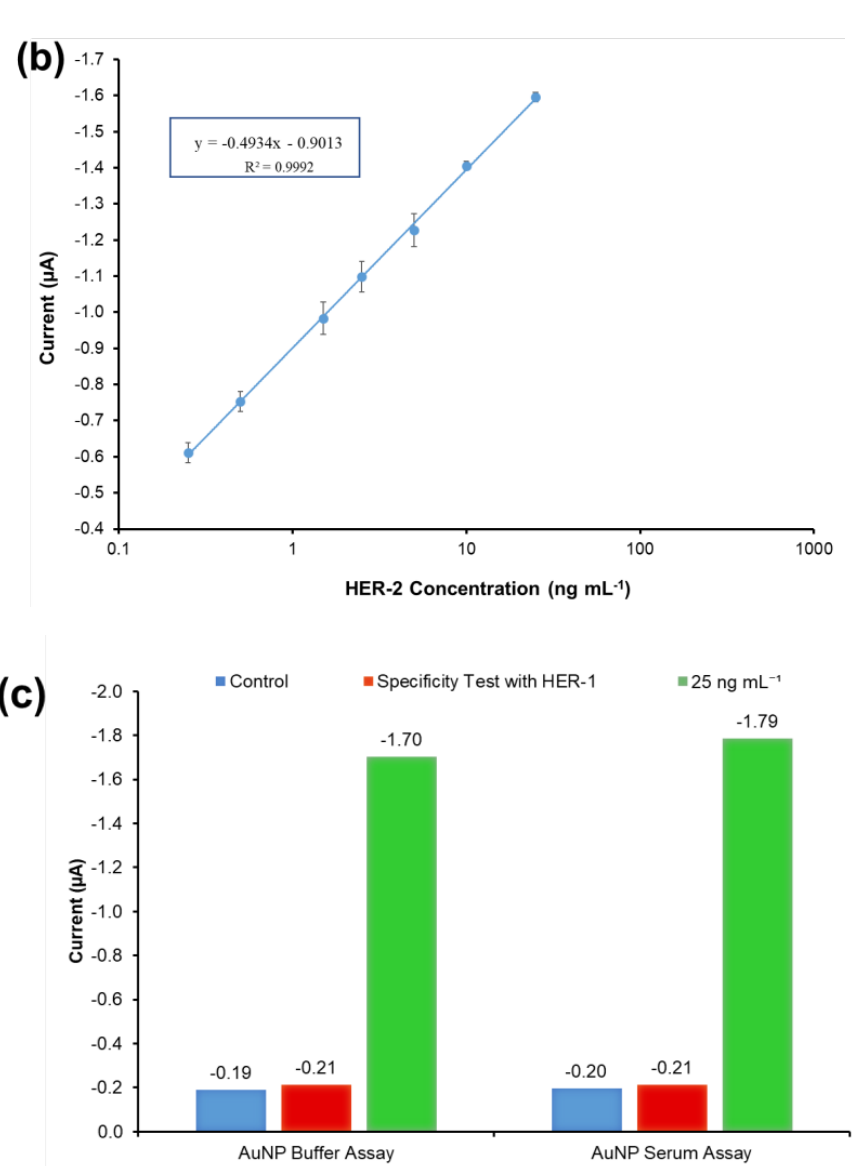
Figure 7. ( a ) Standardized biosensor response of the optimized immunoassay against various concentrations of HER-2 antigen spiked in 100% serum (5–25 ng mL − 1 ); the embedded graph shows the raw chronoamperometry measurements. ( b ) Linear regression of the AuNP-Ab-HRP conjugate assay spiked in serum samples obtained using data taken from Figure 7a. ( c ) Cross-reactivity study of the HER-2 sensor for HER-1 via the indirect ELISA sandwich assay performed using AuNPs-Ab- HRP conjugate as a signal amplification in both buffer and 100% serum. Standard deviations were calculated for experiments performed in triplicate ( n = 3).